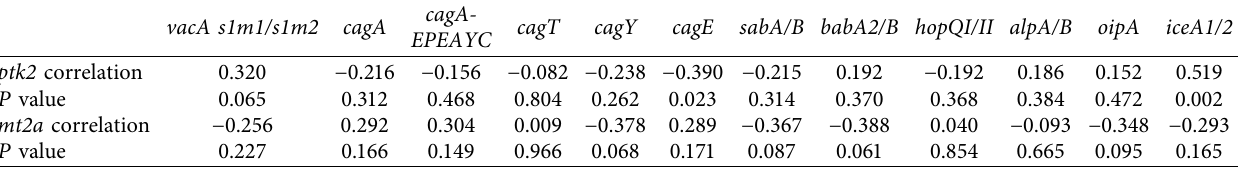
Figure 1: A simple scatter plot of Δ Ct of the ptk2 gene depicts a reverse relationship with R 2 linear 0.057. This means the ptk2 gene expression will increase along with increasing age. Table 7: Correlations between ptk2 and mt2a Δ Ct and gene expression of H. pylori virulence genes in gastric antral epithelial cells of gastritis and gastric adenocarcinoma patients.